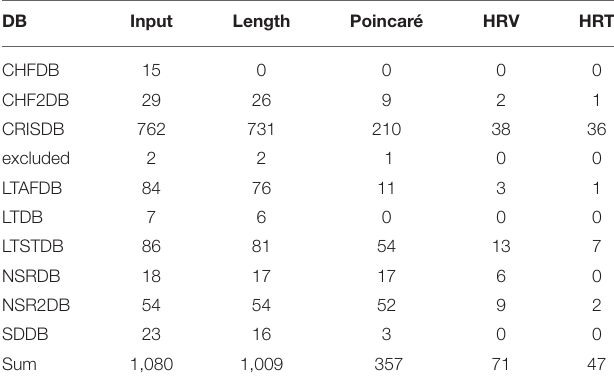
TABLE 5 | Overview of the number of files remaining after every analysis step sorted by their